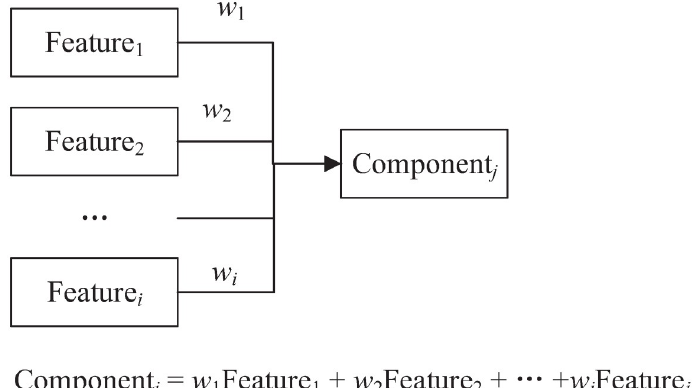
Fig 2. An example of using a component to represent its corresponding features.